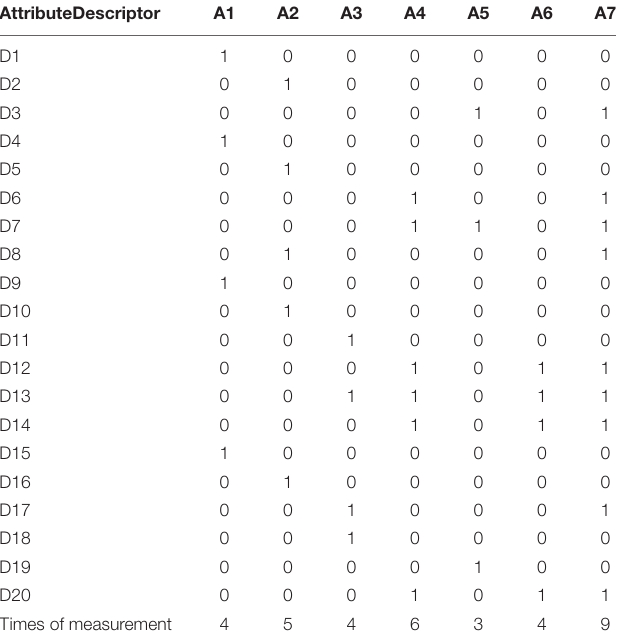
TABLE 5 | The Q-matrix.